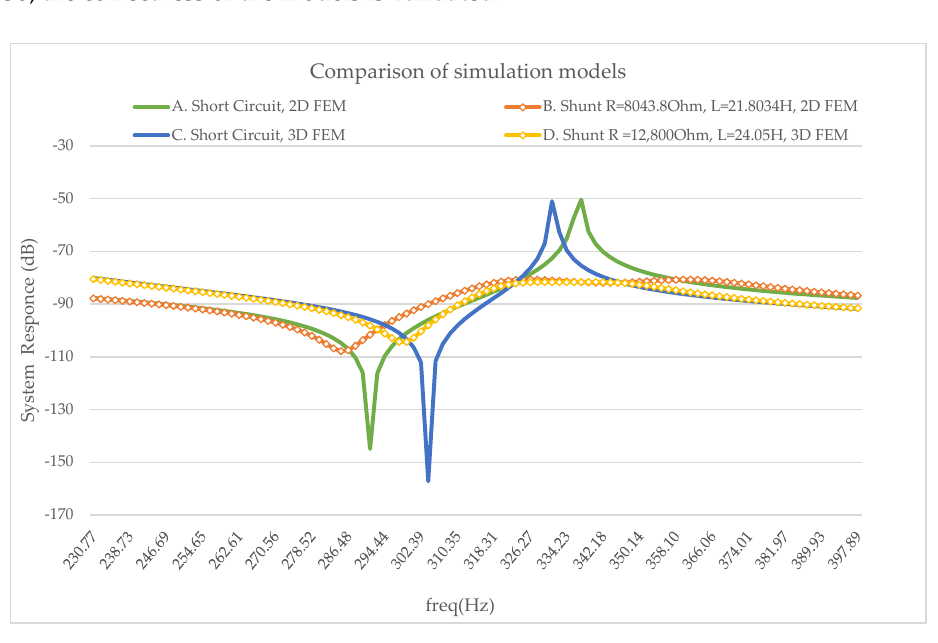
Table 4. Optimal shunt element values based on a 3D FEM model.